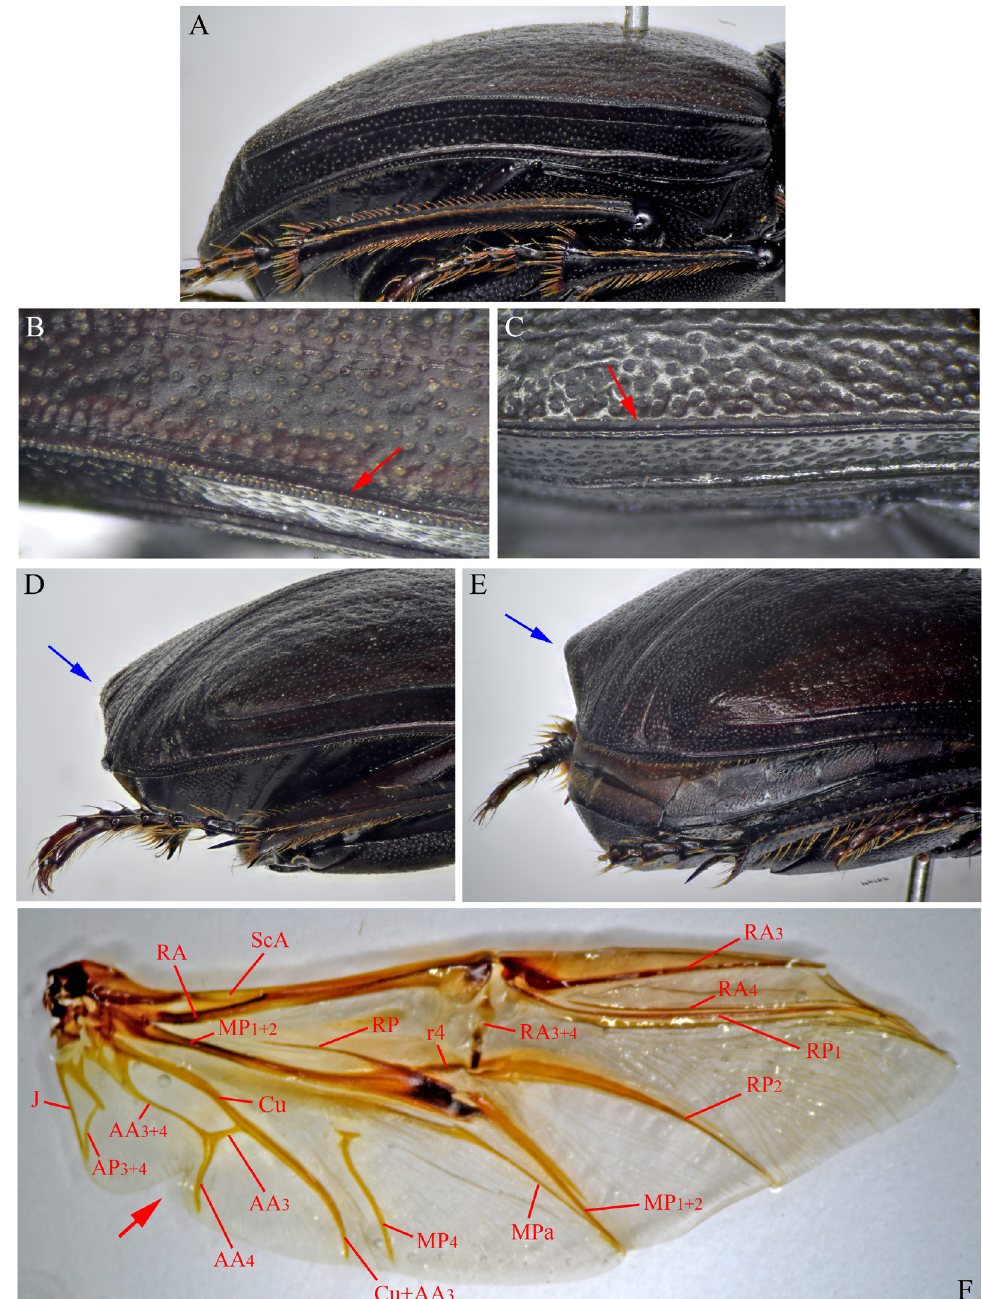
Fig. 21. Wings. A‒E . Elytra. A . Lateral view of elytra of Streblopus opatroides van Lansberge, 1874. Note the very wide pseudepiplera and narrow epipleura. B‒C . Pseudepipleural carina (indicated by red arrows). B . S. opatroides . C . S. punctatus (Balthasar, 1938). Observe that the pseudepipleural carina in B is completely interrupted by umbilicate punctures, whereas the pseudepipleural carina in C is almost completely smooth, with very tiny and isolated punctures. D‒E . Lateral view of apex of elytra. D . S. opatroides . E . S. punctatus . Note how the distal calluses (shown by blue arrows) of S. punctatus are much more strongly projecting than those of S. opatroides . F . Right hind wing of Streblopus opatroides . Red arrow shows the notch of the anal fold. Abbreviations: AA = anal anterior; AP = anal posterior; Cu = cubitus; J = jugal; MP = media posterior; MPa = accessory MP; r = cross-vein r (cross-vein 4 4 connecting veins RA and RP ); RA = radius anterior; RP = radius posterior; ScA = subcosta 3+4 2